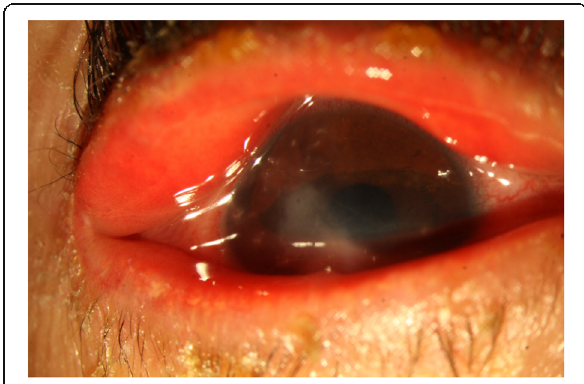
Fig. 3 An infant with a S. epidermidis keratitis with a history of